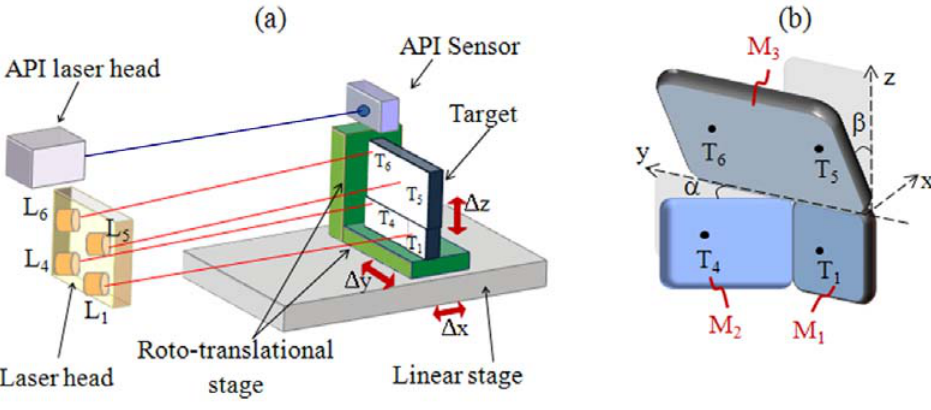
Figure 9. (a) Schematics of the setup for a transverse measuring system. (b) Details of the target